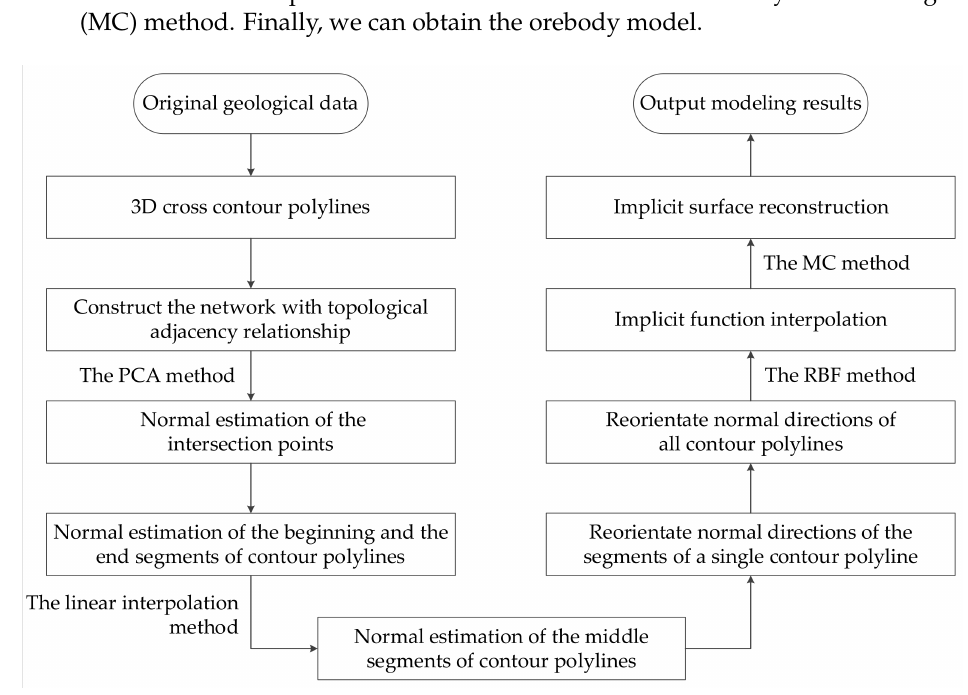
Figure 1. Overall flow chart.